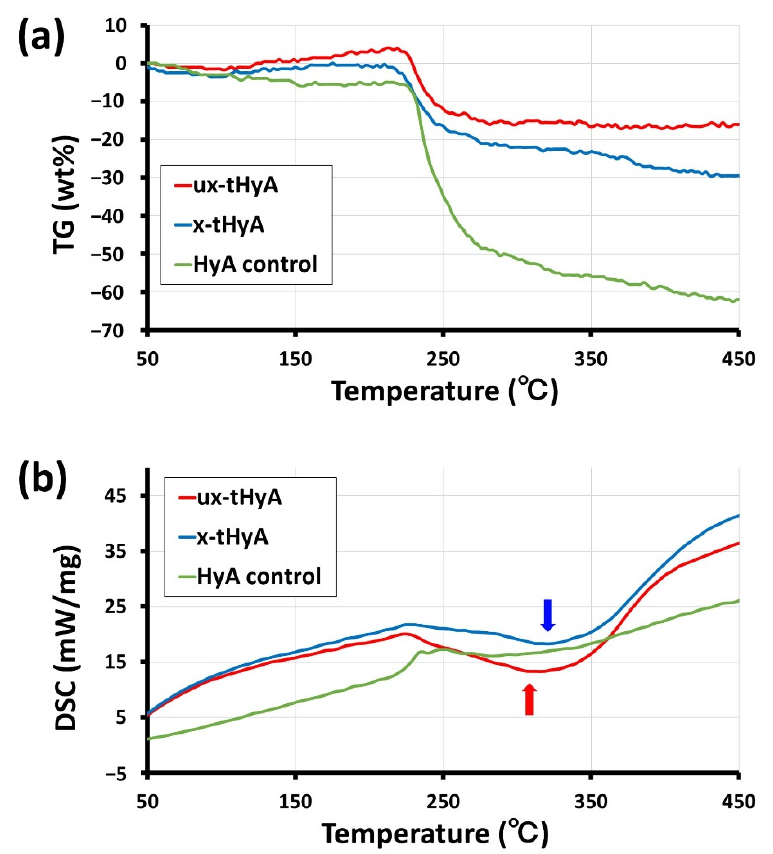
Figure 10. ( a ) TG and ( b ) DSC charts of TG/DSC thermal analyses of dried HyA control, ux-tHyA, and x-tHyA. Note: Arrows indicated peak temperatures of DSC endothermic curves of two samples.